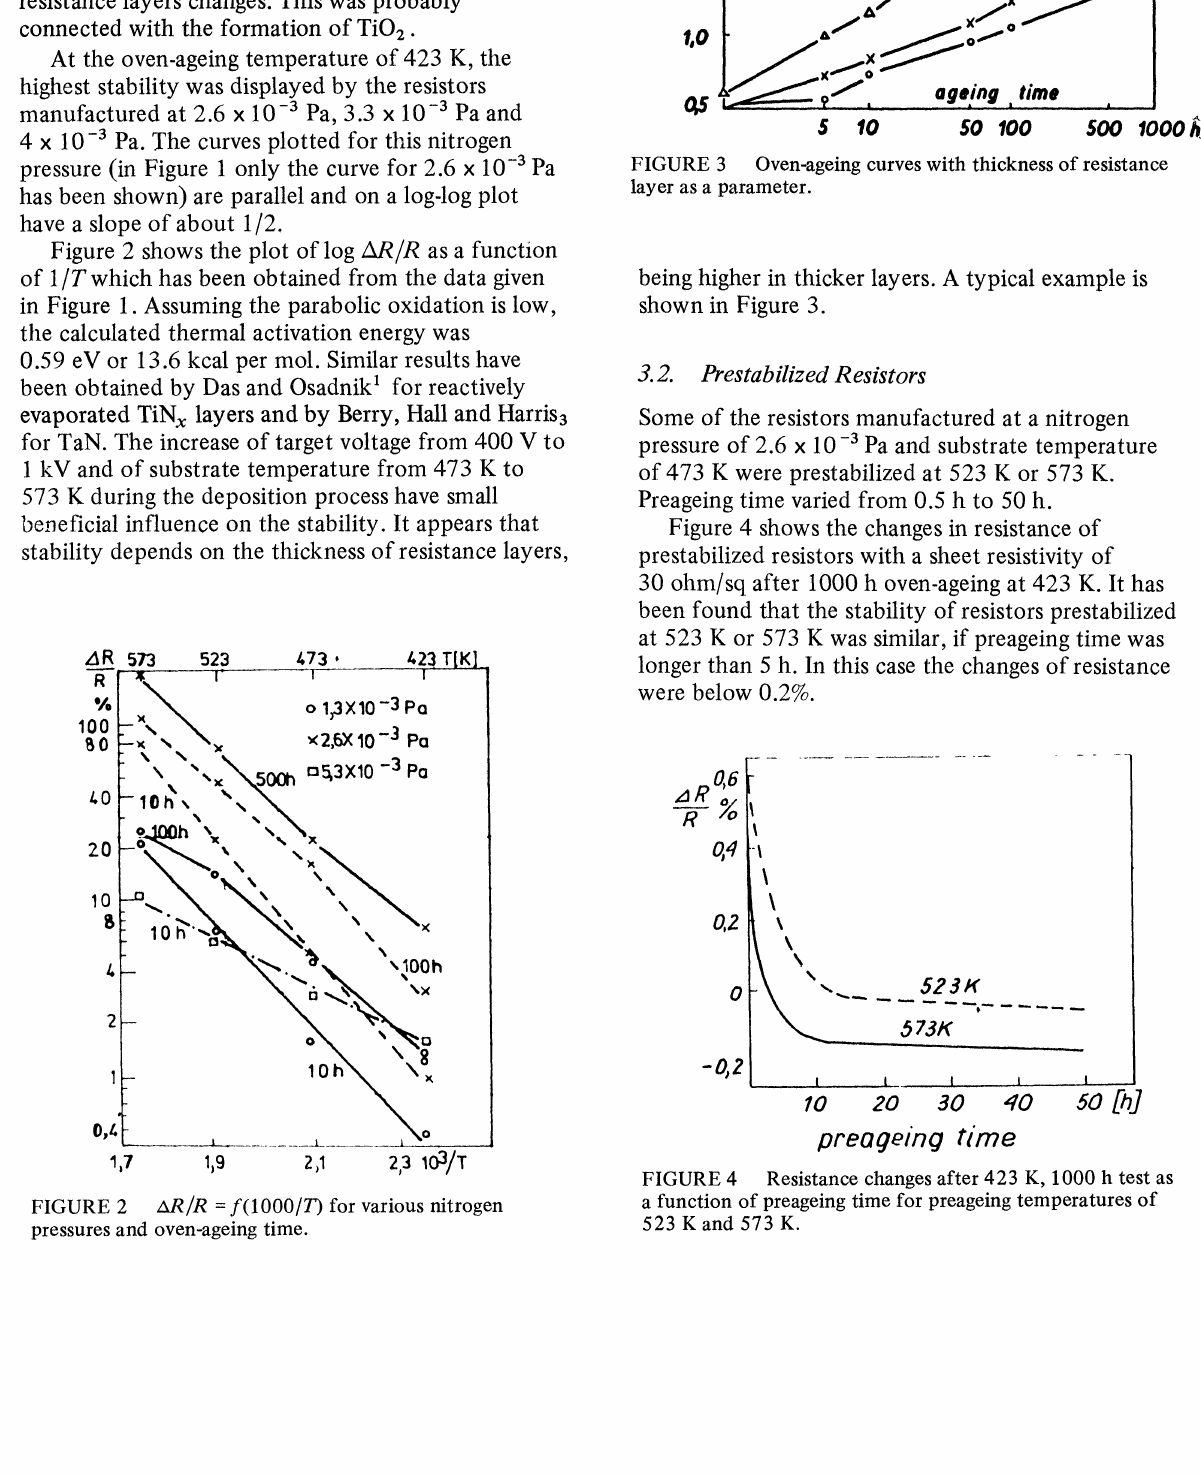
/R f(1000/ for various nitrogen pressures and oven-ageing time.